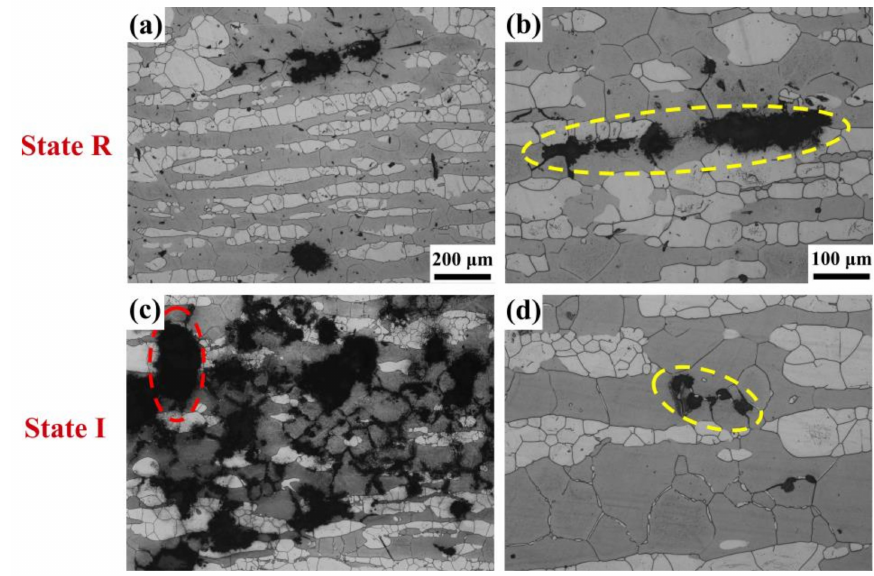
Figure 9. Optical morphologies of the corrosion pits in state R ( a , b ) and state I ( c , d ).